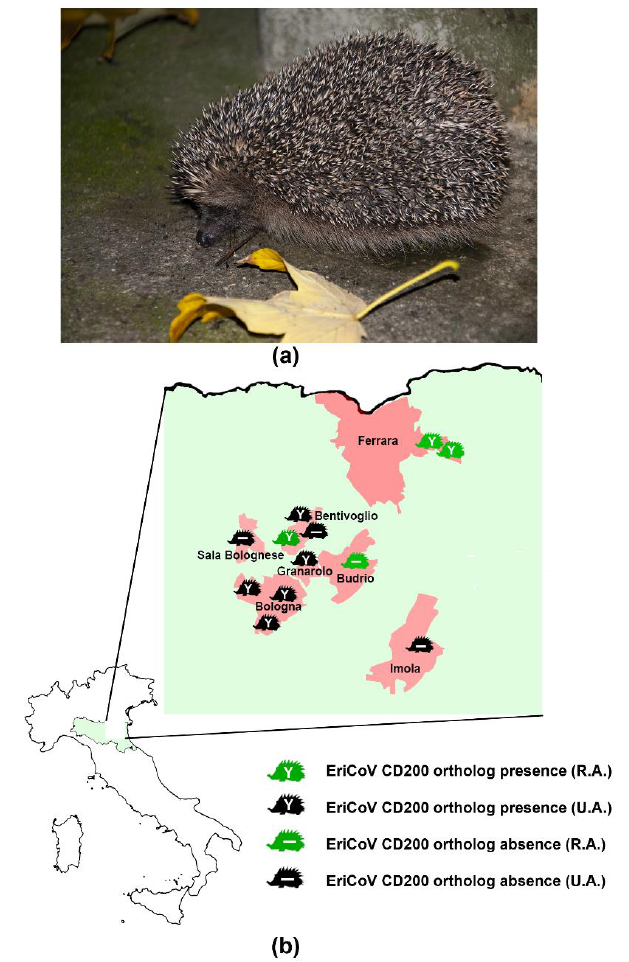
Figure 2. ( a ) Nocturnal image of Western European hedgehog ( Erinaceus europaeus ) from Northern Italy. ( b ) Viral CD200 ortholog in EriCoV strains from 12 hedgehogs sampled in rural areas (R.A.) and urban areas (U.A.) of Northern Italy. See Table 1 for details.